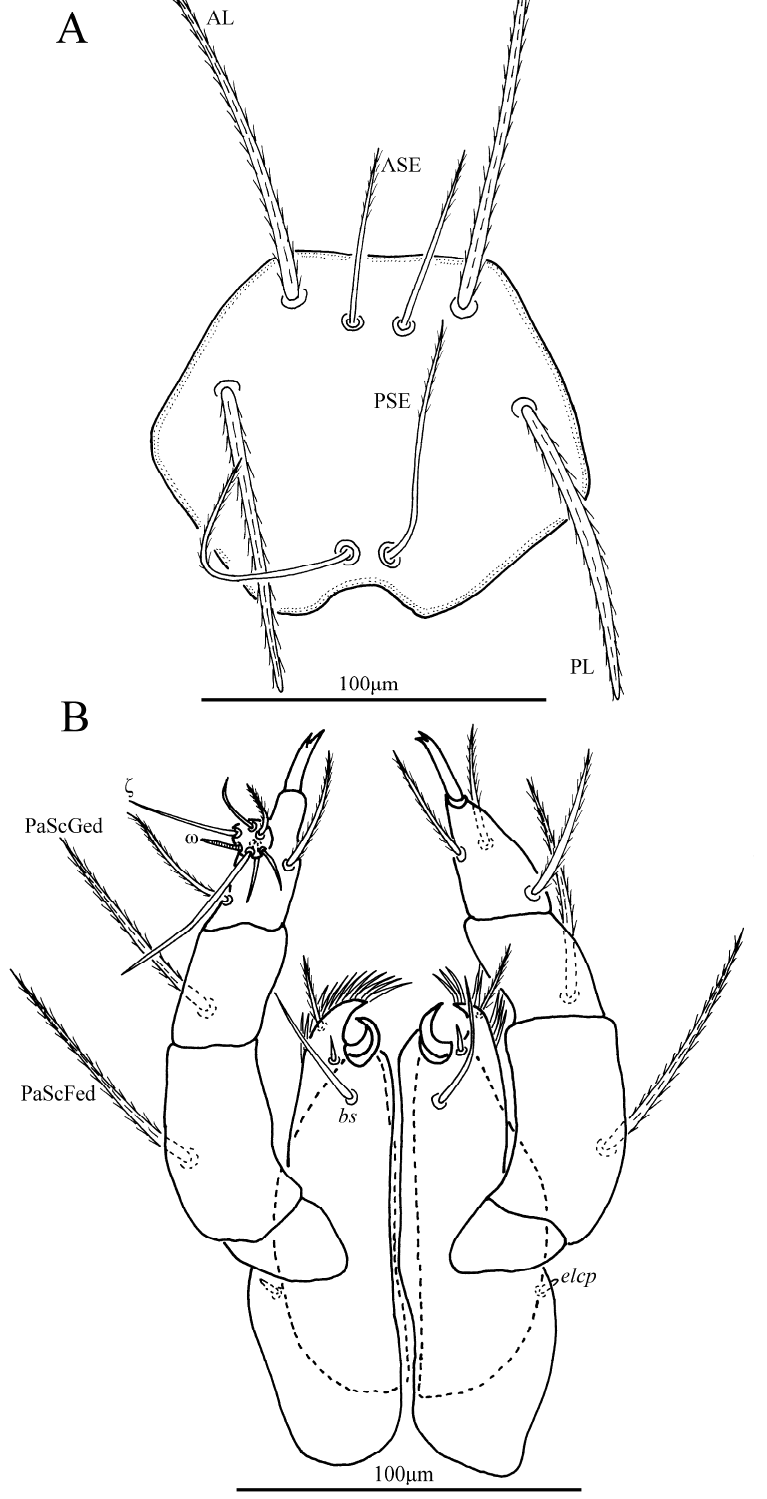
Figure 6. Erythraeus ( Erythraeus ) kunyuensis sp. nov. , larva. ( A ). Scutum. ( B ). Ventral view of gna- thosoma.